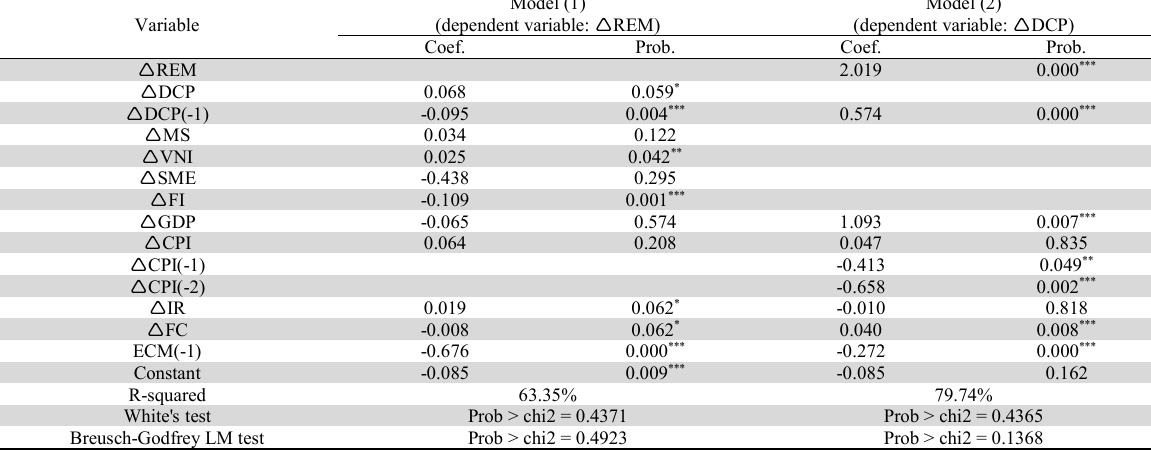
Estimated short-run error correction model